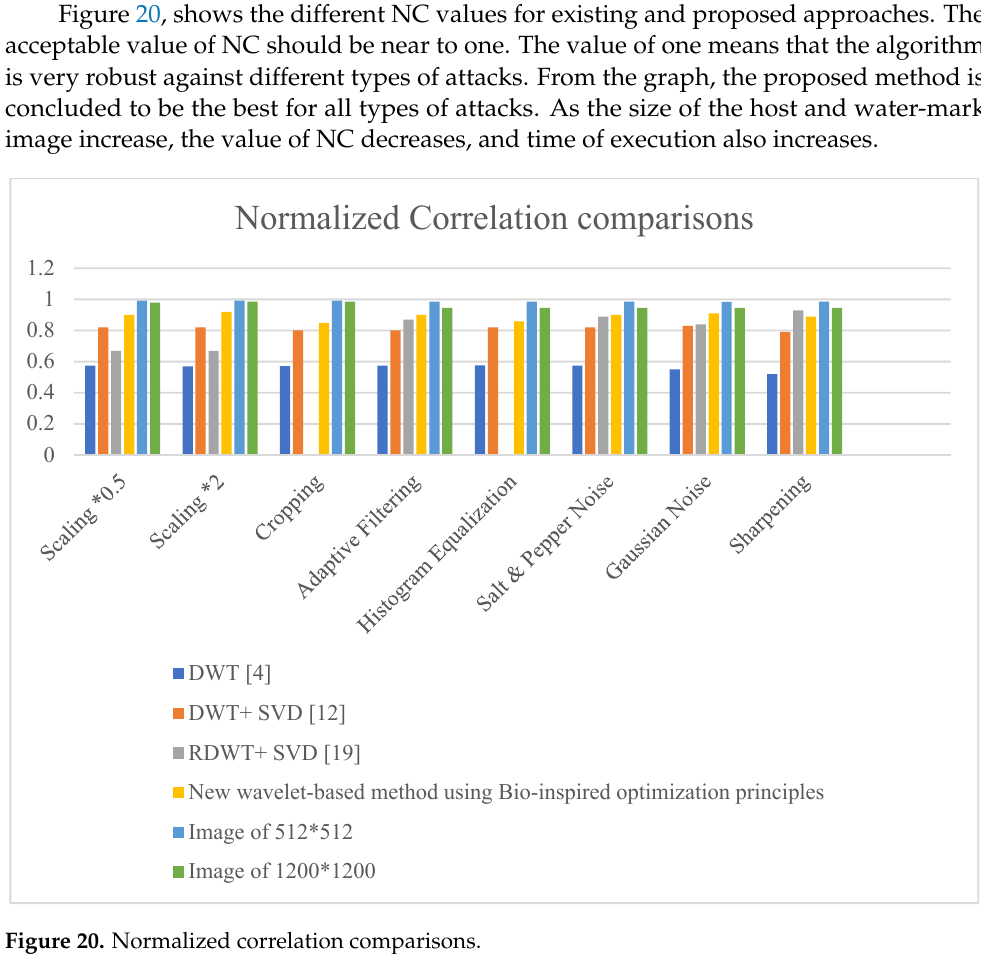
Figure 20. Normalized correlation comparisons.